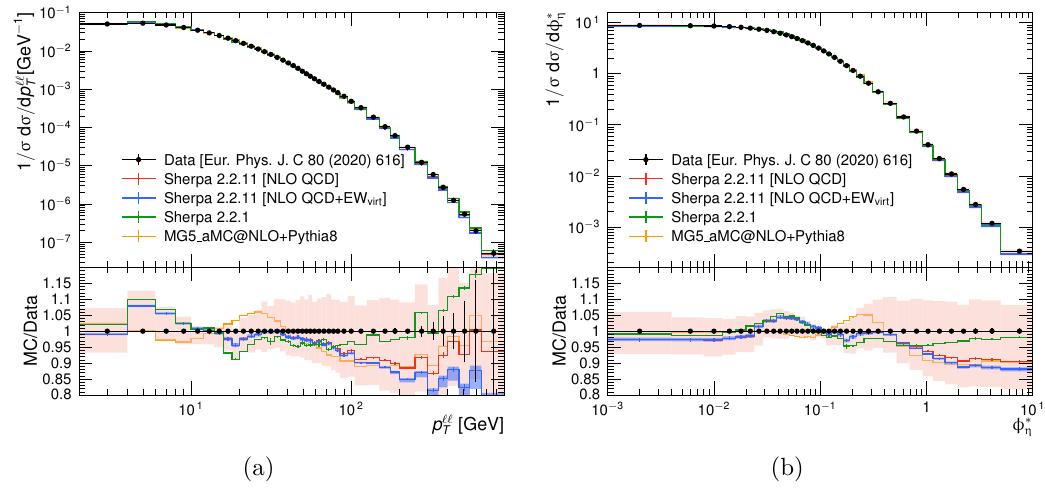
Figure 4 . Unit normalized cross-sections as a function of (a) the transverse momentum of the dilepton system and (b) φ ∗ . Predictions from the Sherpa and MadGraph5_ a MC@NLO+Pythia η are compared with data points taken from the ATLAS measurement [65]. The red uncertainty band corresponds to scale and merging scale variations in the 2.2.11 NLO+QCD Sherpa set-up. The blue uncertainty band is the envelope of multiplicative and exponentiated NLO EW around the additive NLO EW virt